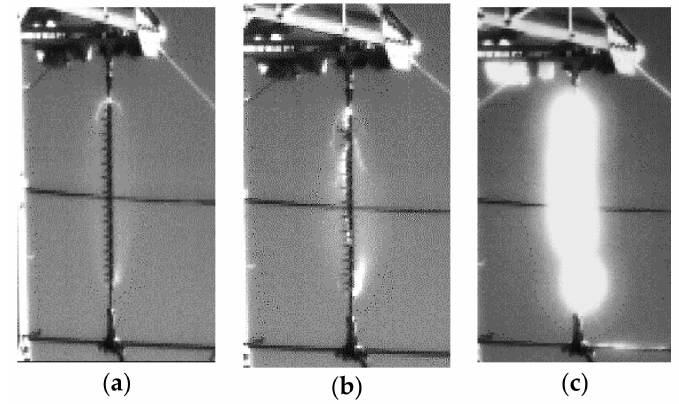
Figure 3. The typical flashover process of composite insulator. ( a , b ) are the process of leader development; ( c ) has formed the entire arc